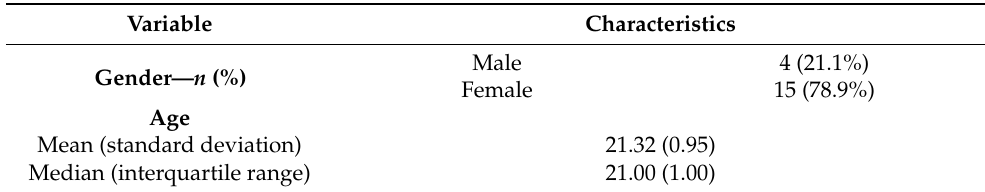
Table 1. Demographic characteristics of the study group.